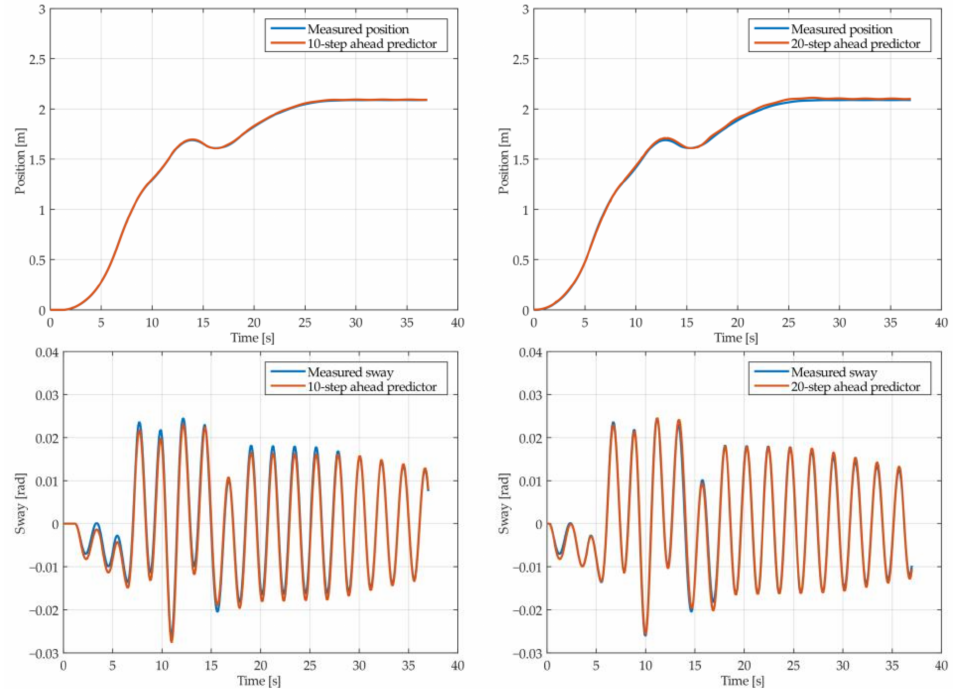
Figure 8. The 10- and 20-step ahead prediction with the MGGP model of the simulated crane position and payload sway with 1.7 m rope length and 10 kg payload